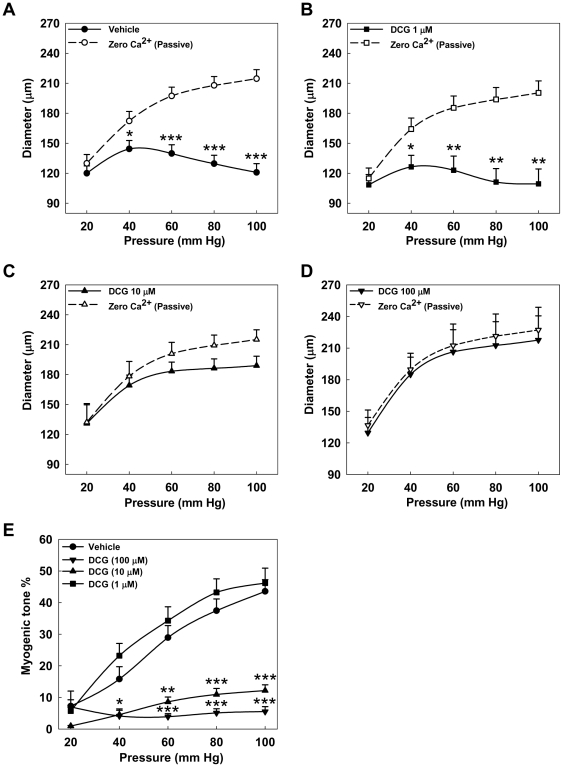
Effect of DCG on myogenic response.(A–D) Fourth-order rat mesenteric arteries pretreated with vehicle and DCG (1, 10, 100 µM) were subjected to a series of intraluminal pressure steps between 20 and 100 mmHg and spontaneous tone was allowed to develop until a stable diameter was achieved (solid lines). The pressure-response was repeated in Ca2+-free physiological salt solution (PSS) with 3 mM EGTA and 0.01 mM diltiazem (dashed lines). Asterisks indicate significant differences between the diameters at each pressure step. (E) Summary data. MT was calculated as the percent difference in diameter observed for Ca2+-containing vs. Ca2+-free PSS at each pressure. DCG (10 and 100 µM) prevented development of MT in small mesenteric arteries. Asterisks indicate significance when compared to vehicle-treated arteries. (n = 5–7 arteries in each group).